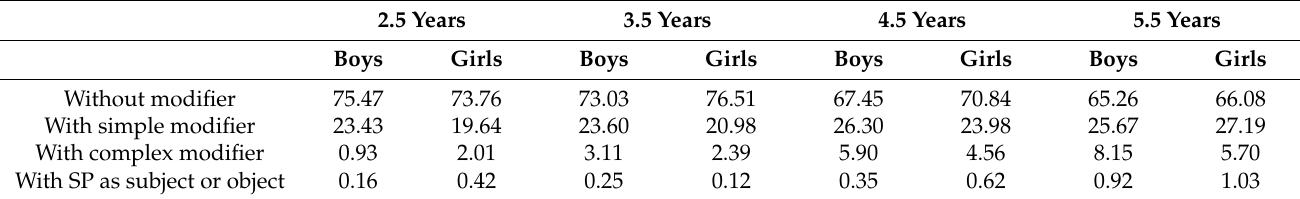
Table 5. Sentence modifiers by age and gender.